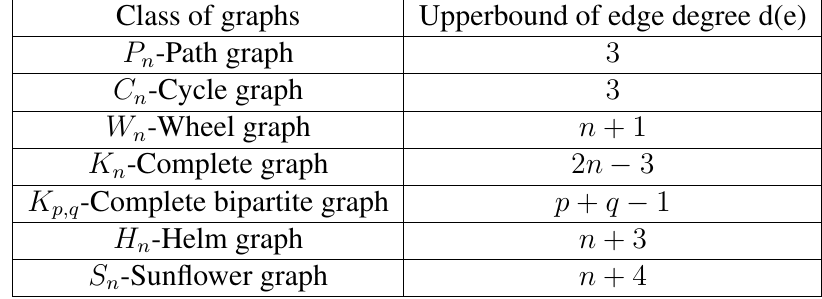
Table 1: Upper Bound-Edge